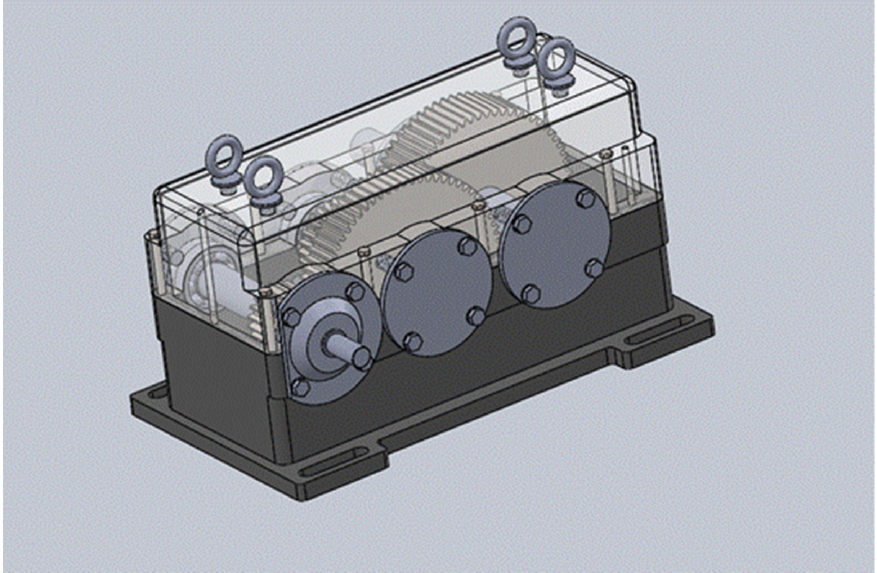
Figure 3. Gearbox designed in Solidworks.